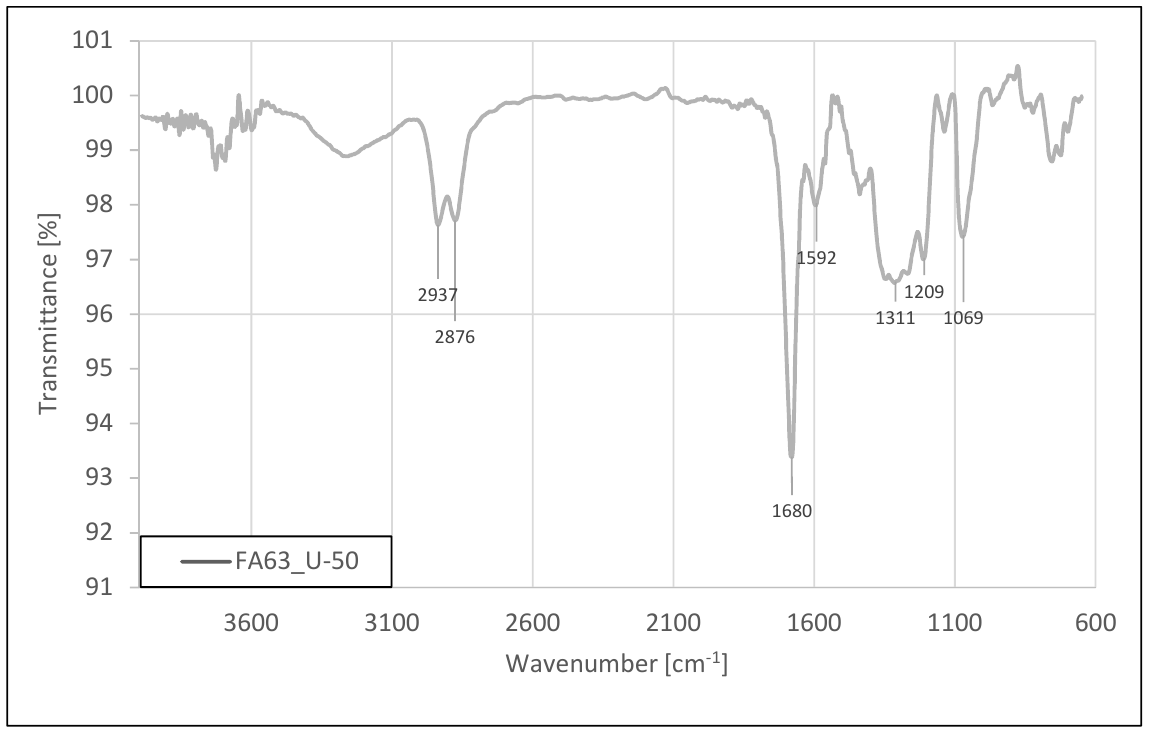
Figure 3. Fourier transform infrared (FTIR) spectroscopy analysis of FA-63 fraction modified by 3-glycidoxypropyltriethoxysilane (U-50).